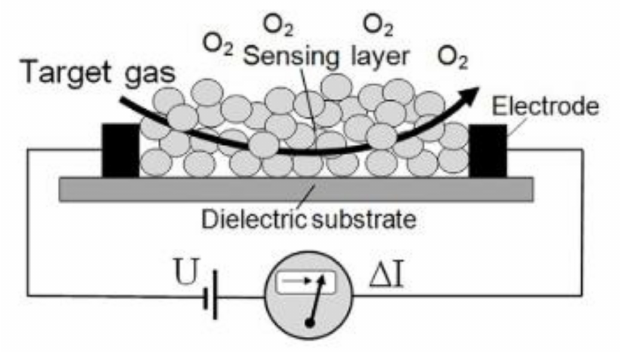
Figure 1. Bar chart of published manuscripts focusing on metal-oxide-based gas sensors.